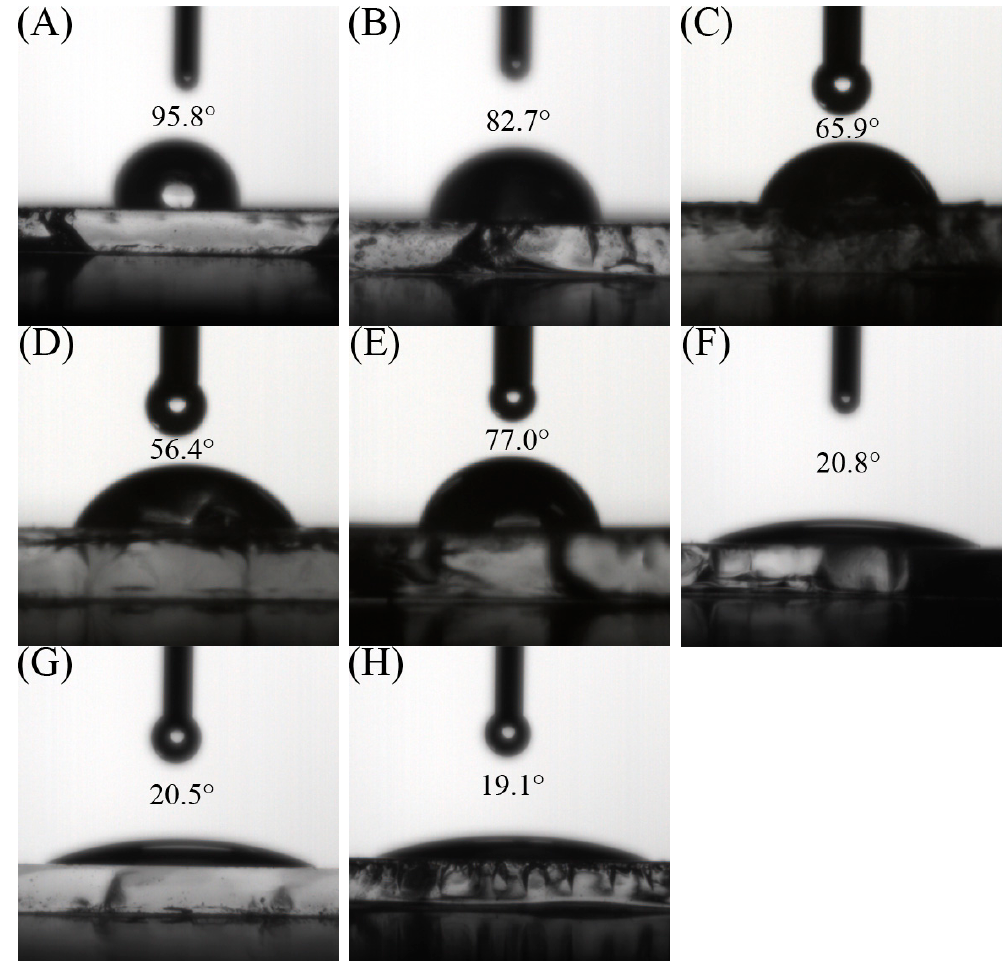
Figure 4. Contact angle images for different polymer films: P4VP ( A ), P1 ( B ), P2 ( C ), P3 ( D ), P4 ( E ), CP20 ( F ), CP40 ( G ), and CP60 ( H ).